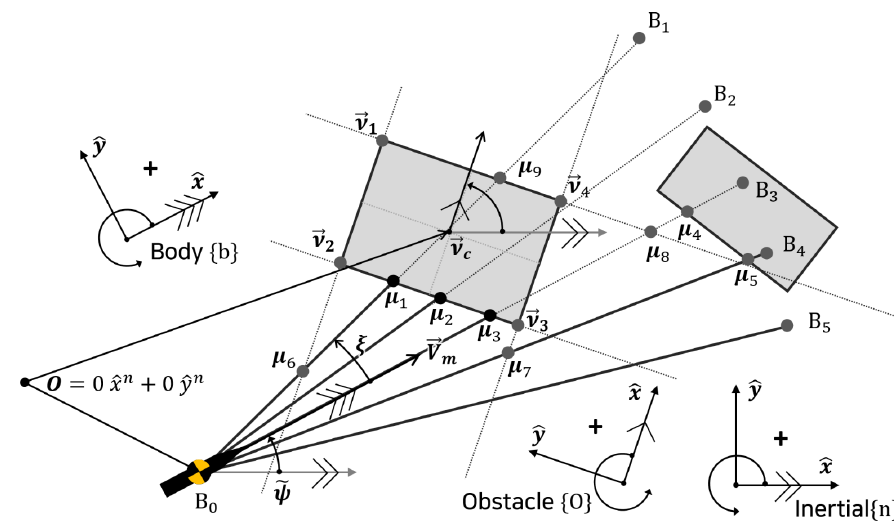
Figure 5. Obstacle detector model.